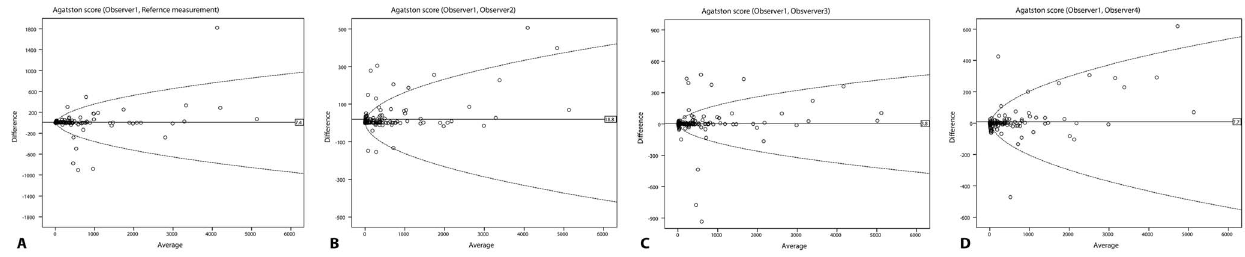
Figure 4. Bland-Altman plots of Agatston score with 95% limits of agreement (dotted lines) comparing the board certified chest radiologist (Observer1) with Reference (A), observer 2 (B), 3 (C), 4